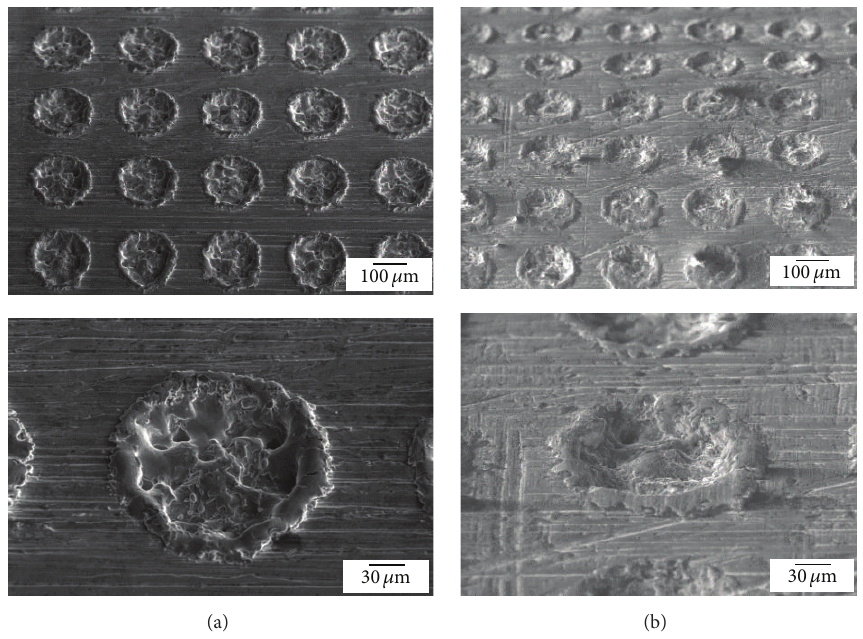
Figure 16: SEM images of die radius—texture #4: (a) before and (b) after hot stamping